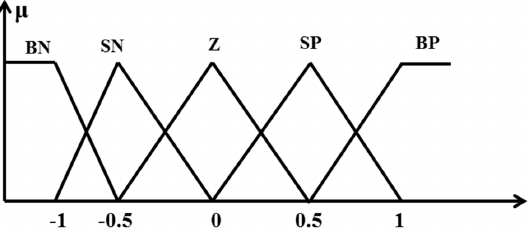
Figure 3. MFs implemented for the FLC.